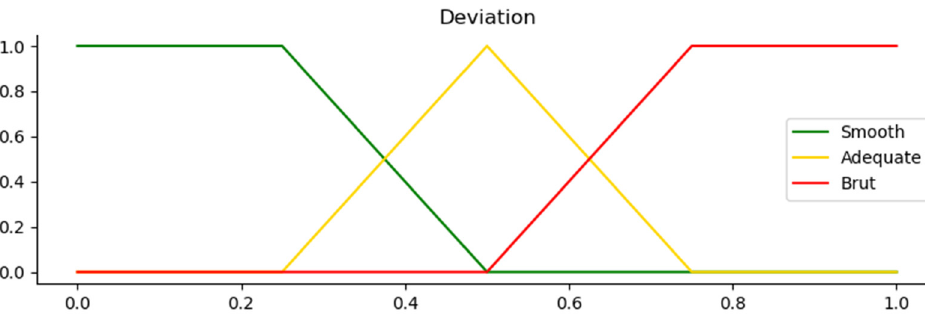
Figure 4. Membership function of Criterion 2 (Equation (2)) of path deviations.